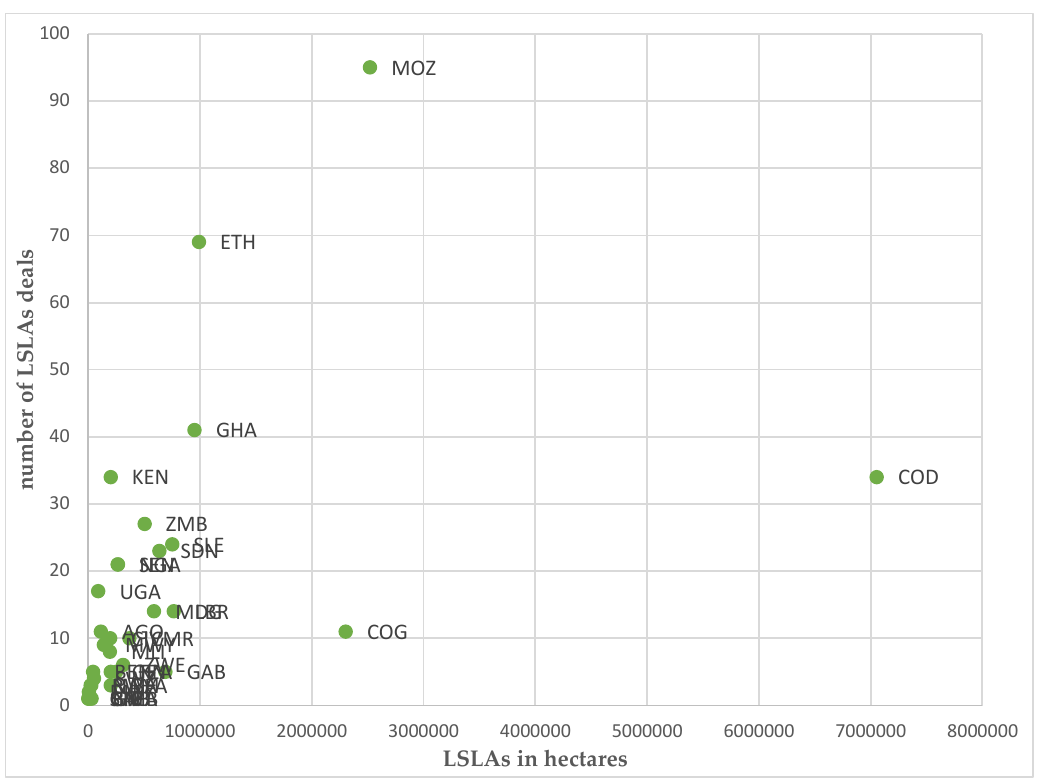
Figure 1. LSLA surfaces of the sample countries in ha.